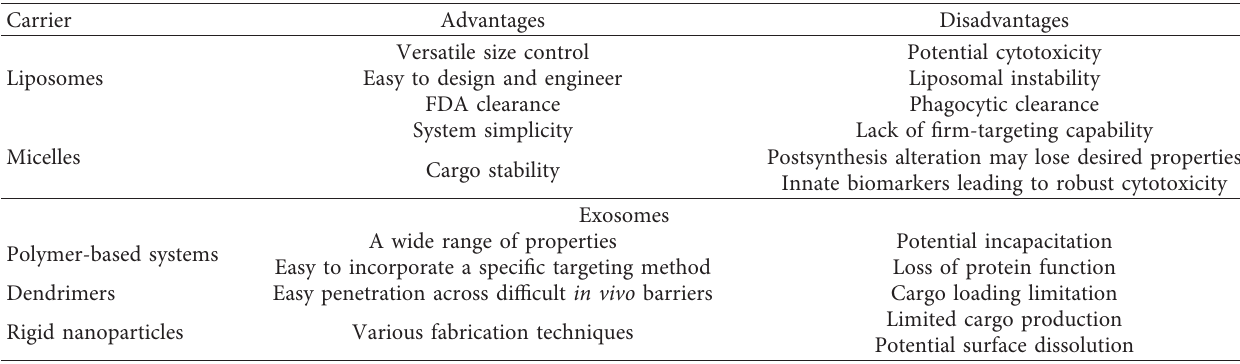
Figure 2: Illustration of nanovesicle types for CRISPR/Cas9 and single-guide RNA (sgRNA) delivery: (a) types of delivery systems for CRISPR/Cas9 and sgRNA and (b) genome-editing mechanisms of nanovesicle-delivered Cas9/sgRNA. Table 1: Nanomedicine systems for prime editing